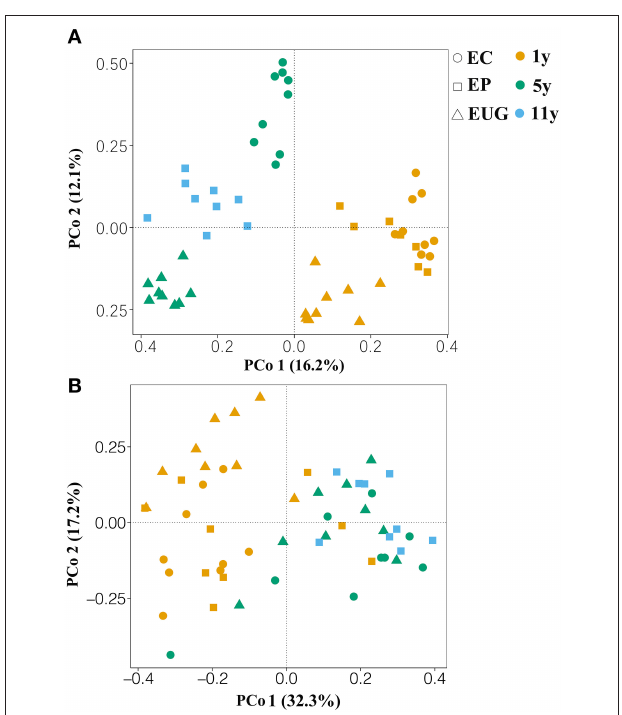
FIGURE 2 | Principle coordination analysis (PCoA) based on Bray–Curtis similarity matrices showing the (A) fungal and (B) functional community structures in different soils. EC, E. camaldulensis ; EP, E. pellita ; EUG, E. urophylla × E. grandis ; 1y, 1 year; 5y, 5 years; 11y, 11